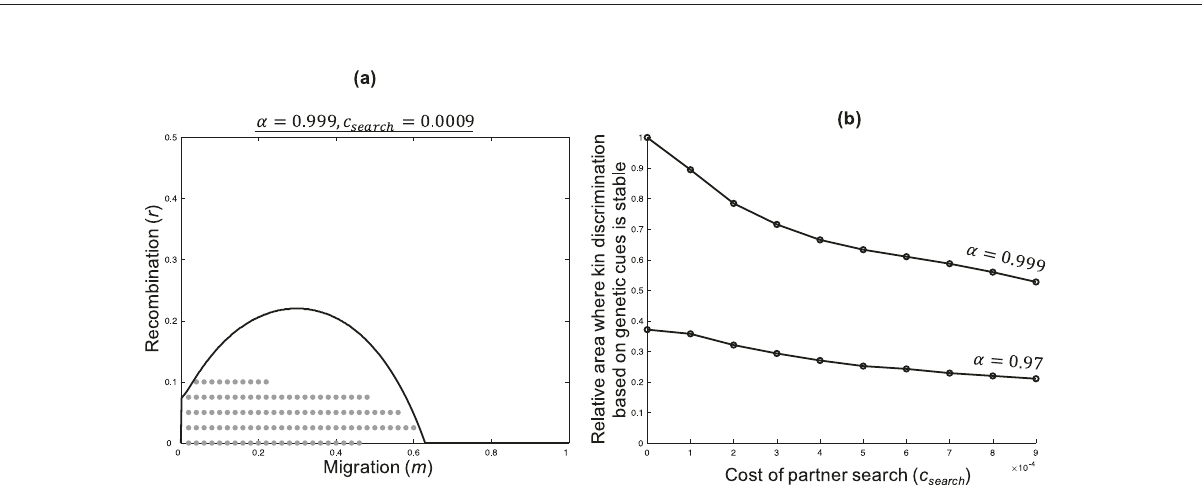
Fig. 5 Search cost. Panel a shows when genetic kin recognition is stable. The area under the solid line shows where kin discrimination is favoured by kin selection (Eq. 1 satis fi ed). The data points show where, for a partner search cost of c search = 0.0009 and encounter parameter of α = 0.999, kin discrimination based on genetic cues is stable. b The Y axis represents the area of parameter space where kin discrimination based on genetic cues is stable for given values of c search & α , divided by the area it is stable when c search = 0 & α = 1. As the search cost ( c search ) increases, the area where genetic kin recognition is favoured drops off relatively slowly, especially when α is lower. We assumed: µ Trait = 0.001, b = 0.3, c = 0.1, L max = 100, N = 30; kin discrimination based on genetic cues is stable when >10 tags maintained and helping frequency